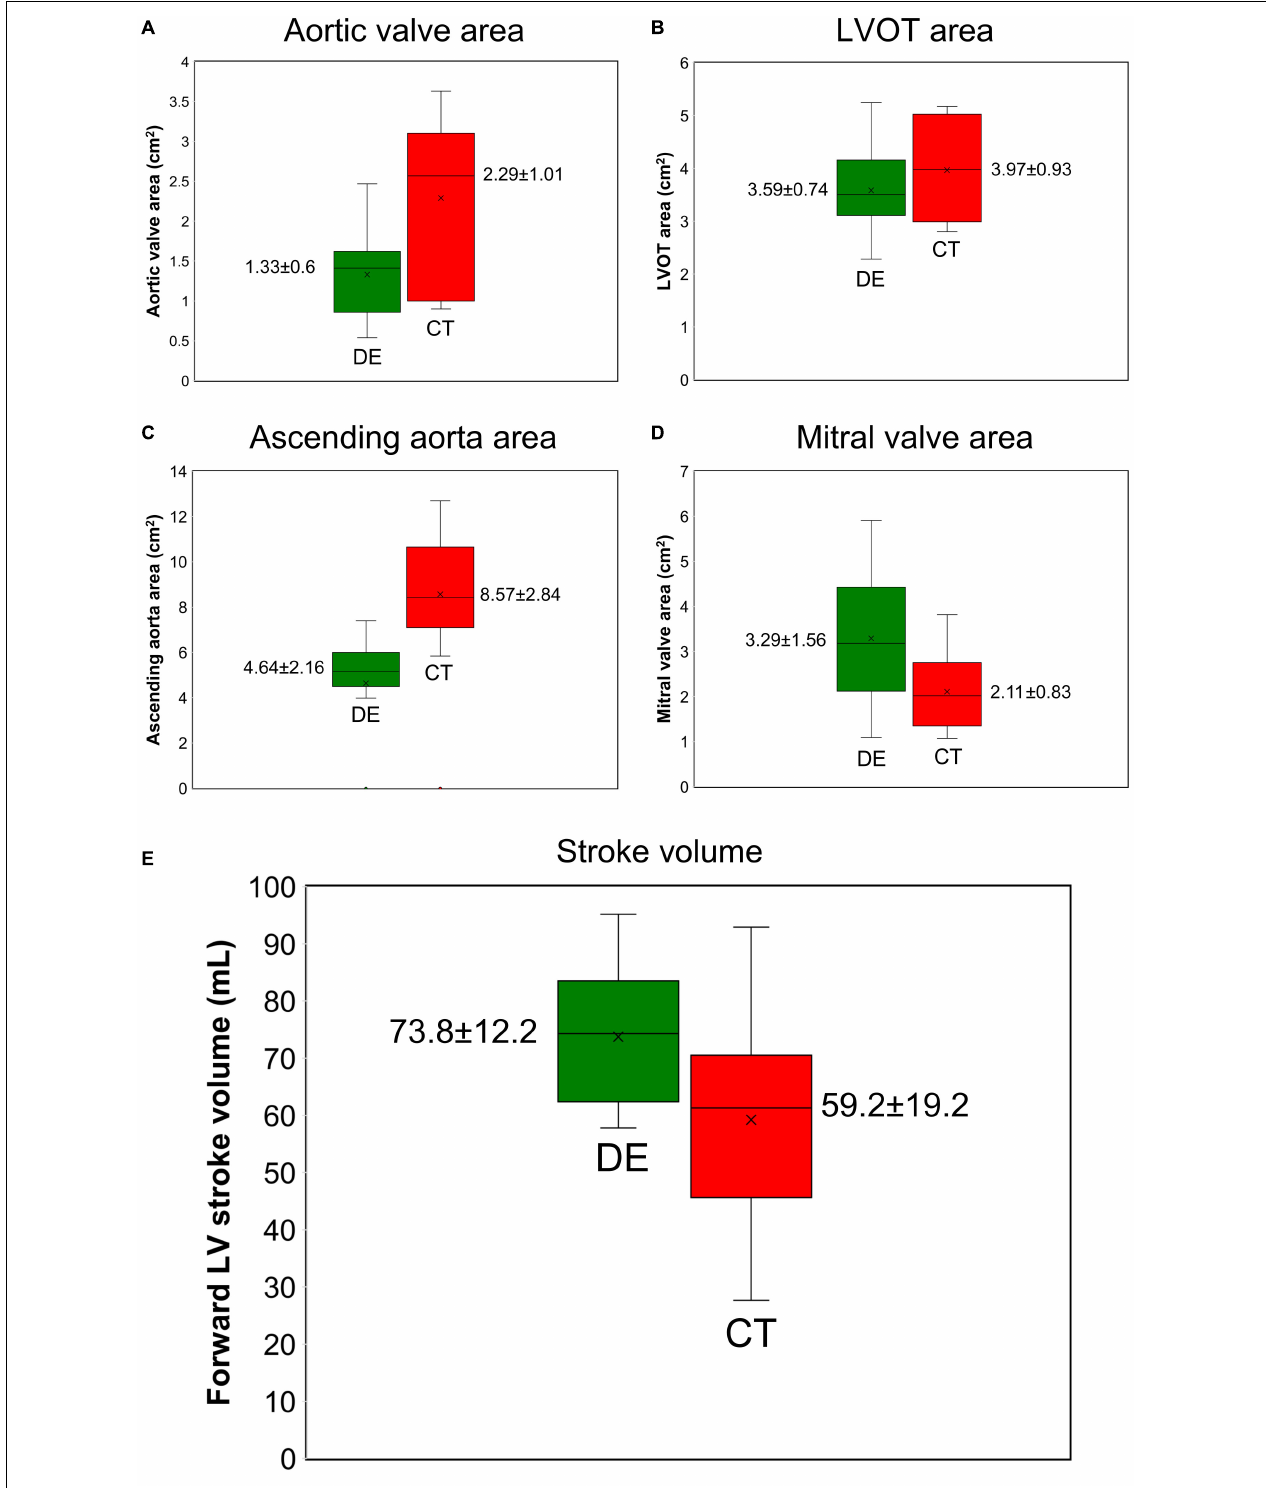
FIGURE 5 | Doppler echocardiography measurements vs. computed tomography measurements ( N = 49). (A) aortic valve effective orifice area; (B) LVOT area; (C) ascending aorta area; (D) mitral valve effective orifice area; (E) forward LVOT stroke volume. DE and CT generated significantly different results for aortic valve effective orifice area, LVOT area, ascending aorta area, mitral valve effective orifice area, and forward LVOT stroke volume as the two sample t -test rejected the null hypothesis at 0.01 significance level.